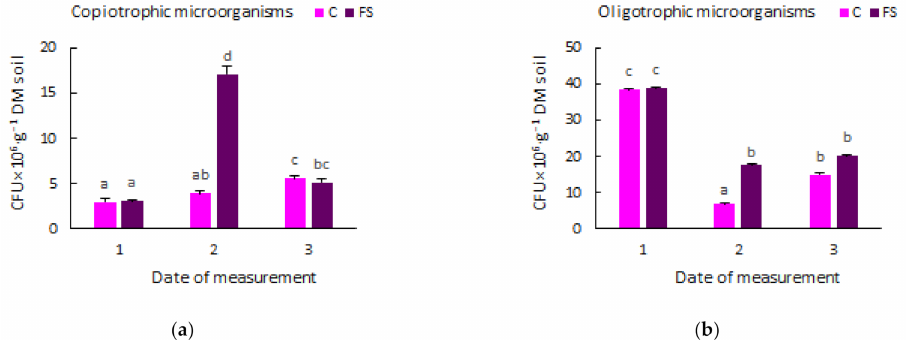
Figure 4. The number of ( a ) copiotrophic and ( b ) oligotrophic microorganisms in soil after fertilisation. Different letters above the error bars (i.e., ± SD) indicate significant differences ( p < 0.05) between means (Tukey post-hoc